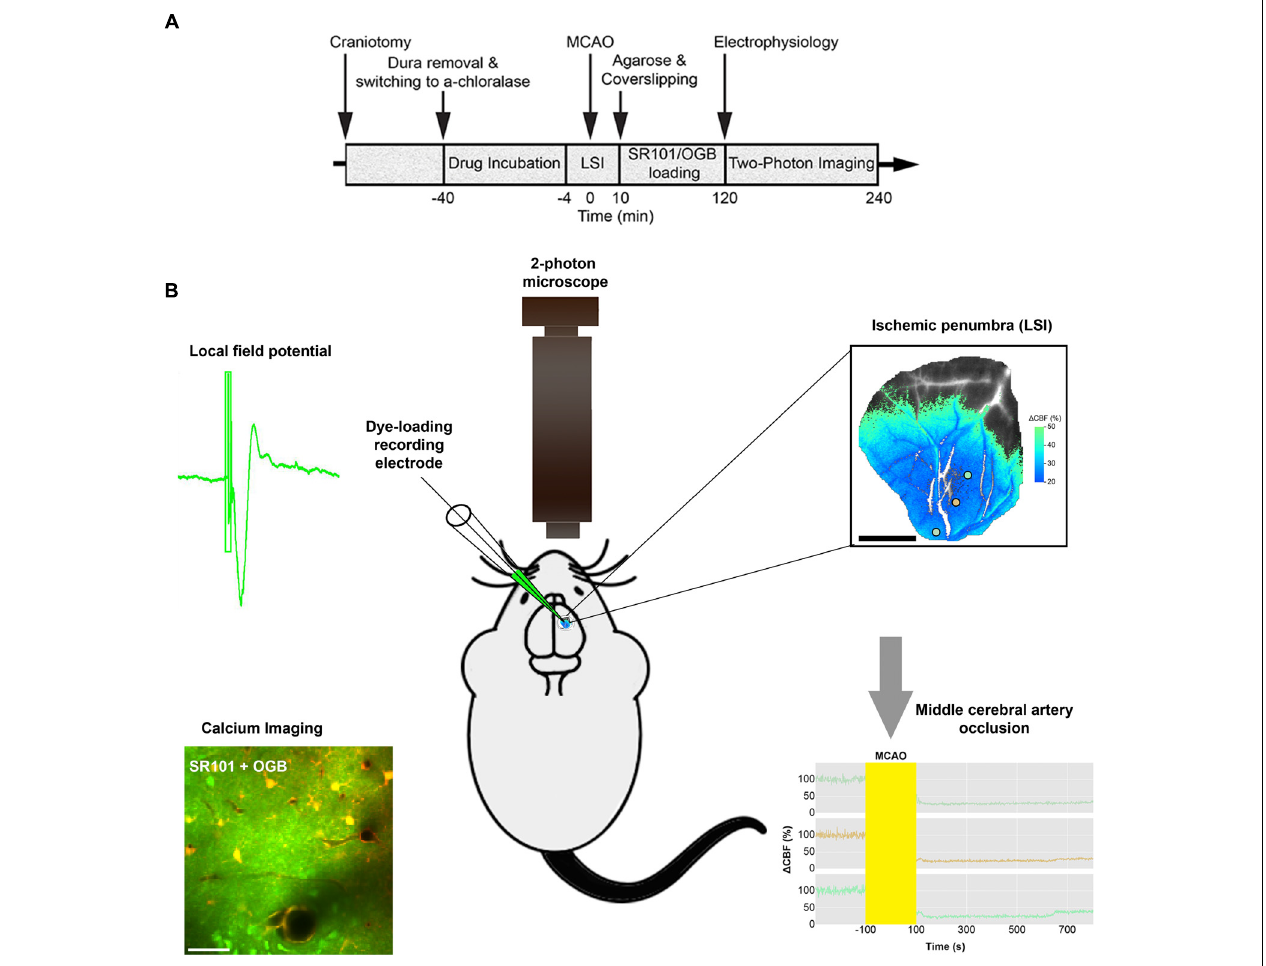
FIGURE 1 | Diagram of the experimental timeline and the set-up. (A) Permanent Middle cerebral artery occlusion (MCAO) was induced during laser speckle imaging (LSI) of cerebral blood flow (CBF). (B) Extracellular local field potentials (LFPs) were recorded using a single-barreled glass micropipette that also contained the Ca 2 + -sensitive dye Oregon Green 488 BAPTA-1/AM (OGB) and the astrocyte-specific marker sulforhodamine 101 (SR101). The same micropipette was used for recording local field potential and calcium responses simultaneously in the ischemic penumbra which covered 3/4 of the craniotomy as confirmed by Laser